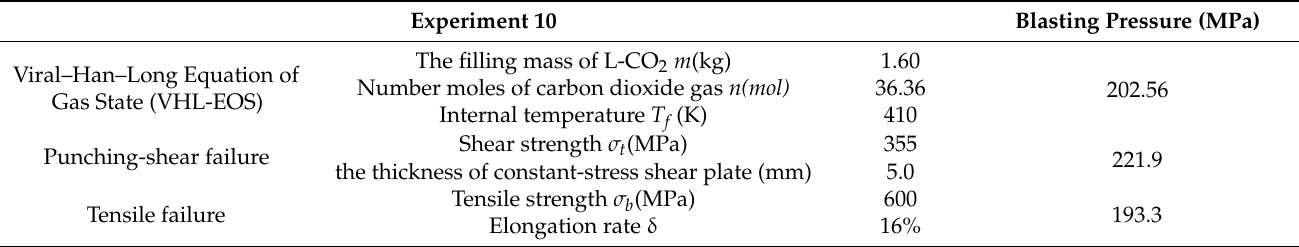
Table 2. Blasting pressure of experiment